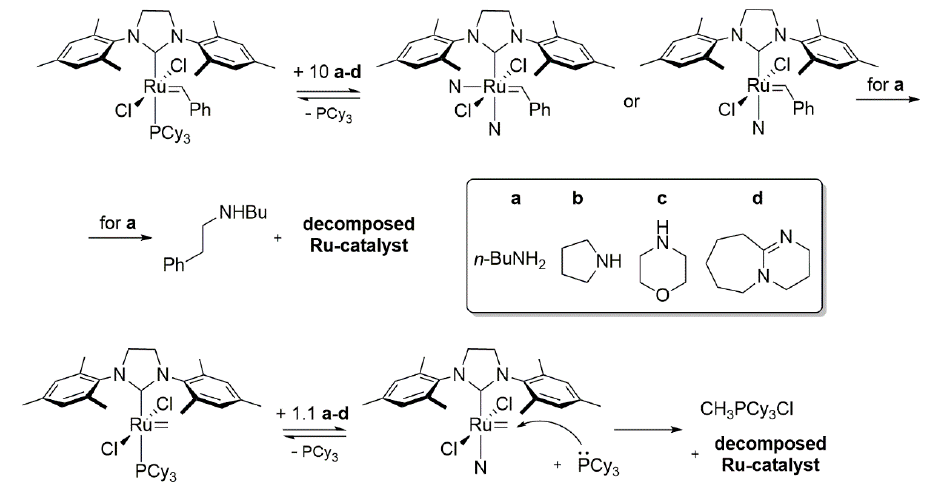
ruthenium complexes stability towards